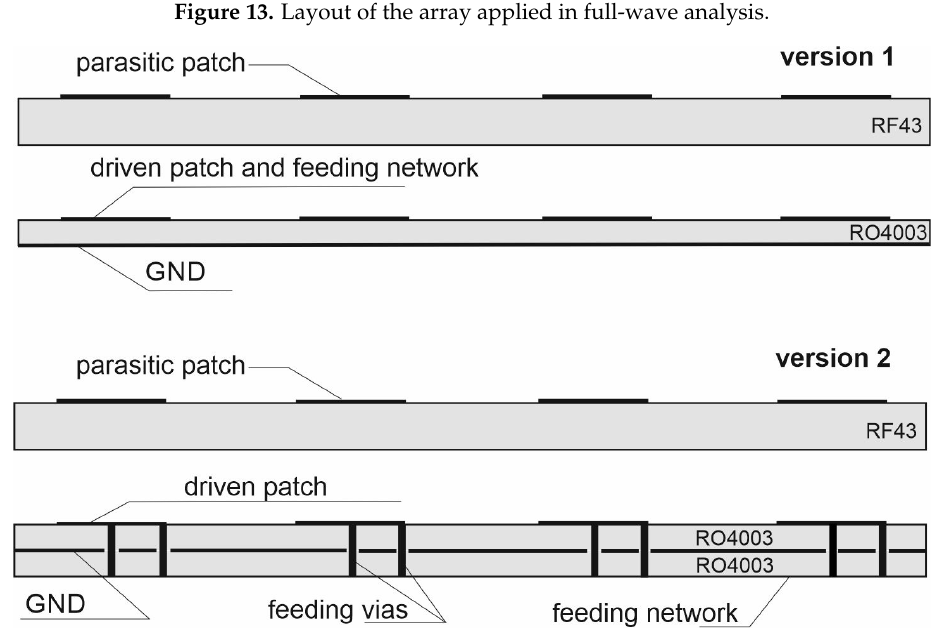
Figure 14. The cross-sections of the array